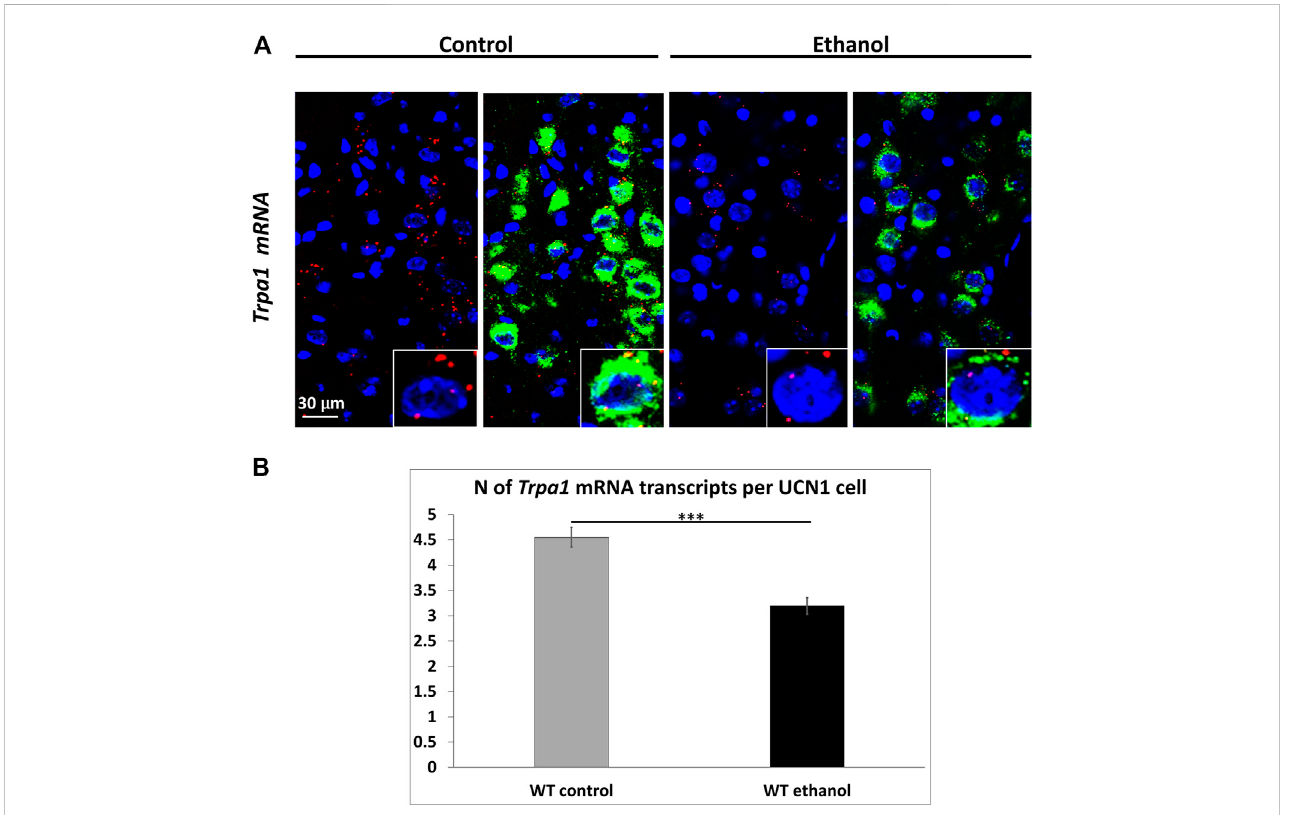
FIGURE 4 Trpa1 mRNA expression in the centrally projecting Edinger – Westphal nucleus (EWcp) of control and ethanol-treated mice. (A) Representative fl uorescenceimagesshowingtheexpressionof Trpa1 mRNA(red)byRNAscope insitu hybridizationanditsco-localizationwiththeurocortin1(UCN1)peptide (green) by immuno fl uorescence, in the EWcp of Trpa1 wildtype (WT) mice 2 h after i.p., saline (control) and 1 g/kg ethanol injection. For nuclei, the sections were counterstained with 4 ′ ,6-diamidino-2-phenylindole (DAPI) (blue). (B) Quantitative evaluation of Trpa1 mRNA expression in the EWcp of WT mice, 2 h after i.p., saline (control) and 1 g/kg ethanol injection. Columns show means ± SEM of Trpa1 mRNA transcripts in the EWcp ( n = 6 – 8; *** p = .0001; Student ’ s